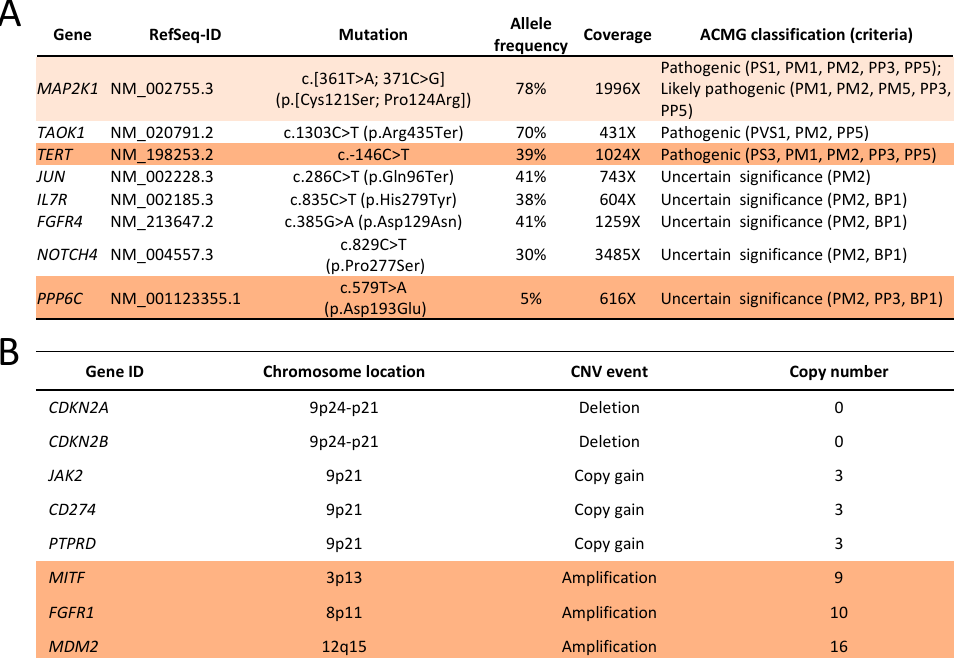
Figure 3. PET images and treatment of the patient. ( A ) Whole body PET images, showing tracer accumulation in tumour lesions; ( B ) Cross section of the PET images, showing responses of a liver lesion (upper panel) and para-aortic tumour masses during the therapeutic interventions; ( C ) Schematic time course of the MEK inhibitor treatments and responses.